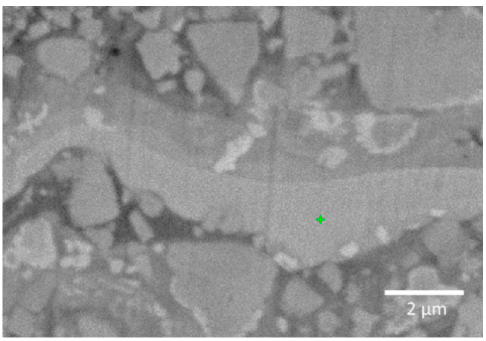
Figure 8. SEM micrograph in the cross-section of the two-layers WC-12Co coating were the presence of intermetallic phases can be observed.